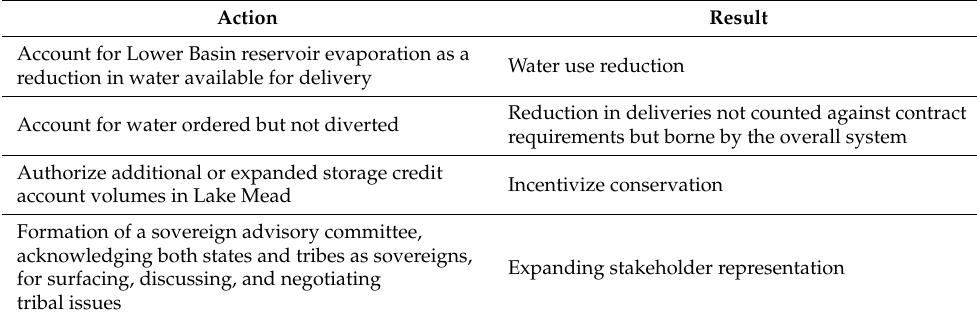
Table 1. Possible near-term unilateral federal actions (for details, see Supplemental Materials Table S1).